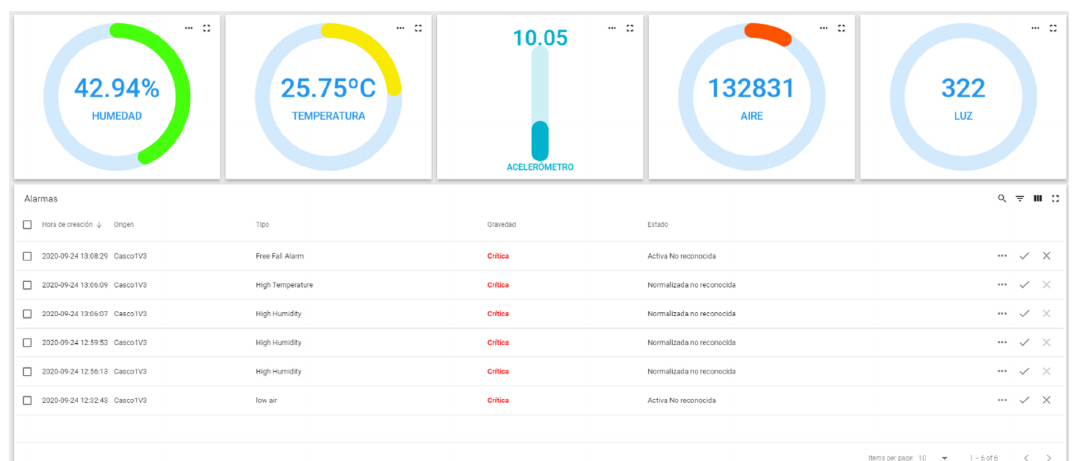
Figure 6. Final configuration of ThingsBoard platform to be validated through an intelligent algorithm.